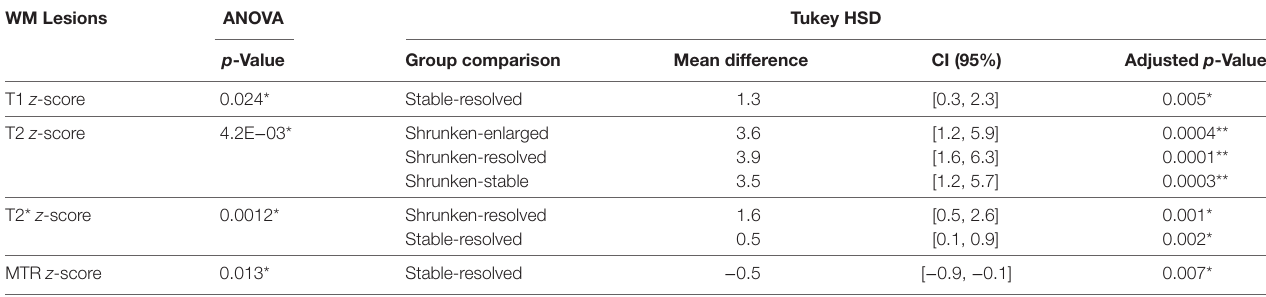
TaBle 5 | Analysis of variance (ANOVA) and Tukey HSD test on Tp1 QMRI z -scores across lesions groups.